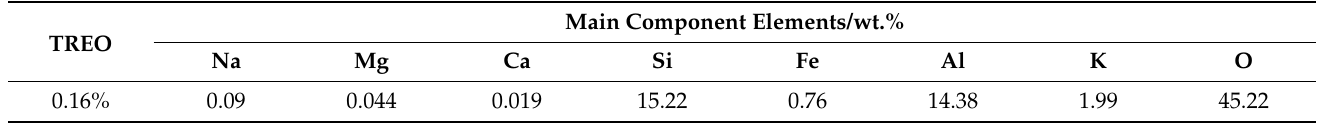
Table 1. Main chemical composition and the total amount of rare earth oxides of IREOs. Main Component TREO